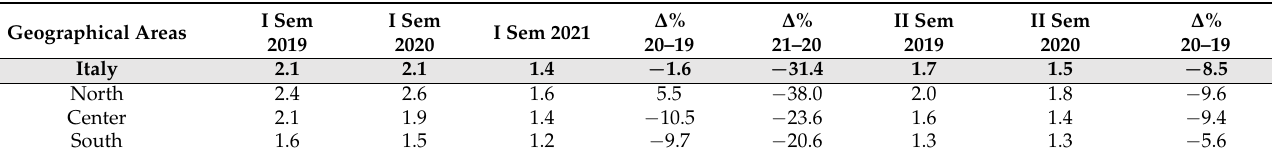
Table 2. Consumption (DDD/1000 inhabitants per day) of antibiotics for systemic use (J01) in the hospital setting: comparison